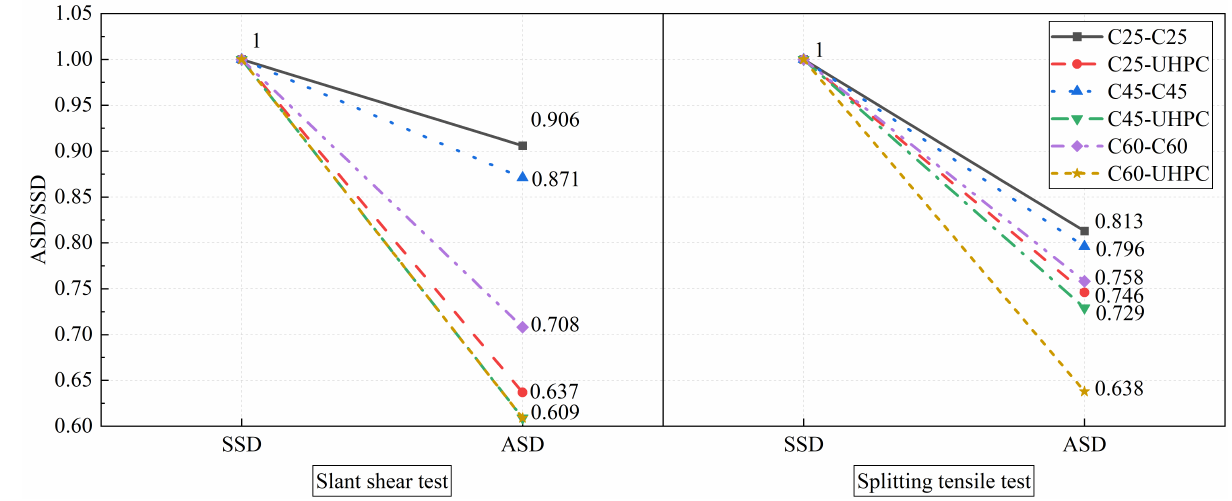
Figure 5. Effects of different moisture degrees of the substrate on the interfacial bond strength.